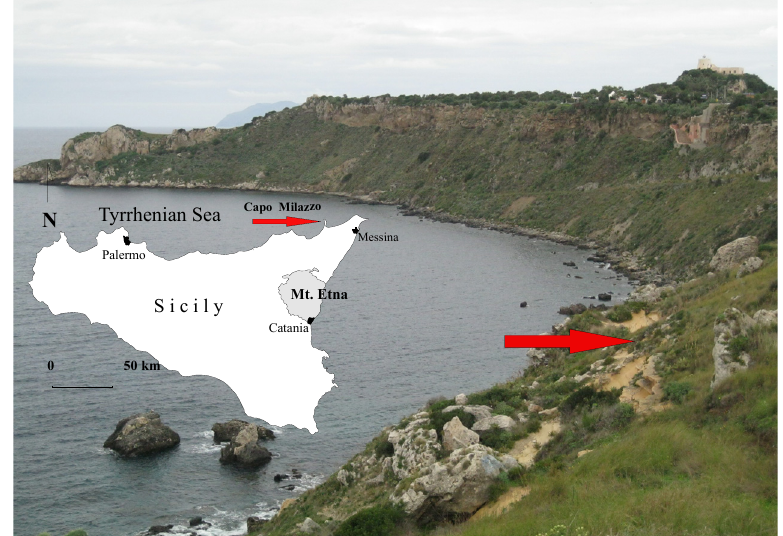
Figure 1. Geographical location of the Cape Milazzo Peninsula and Cala S. Antonino with the sandy-silty succession (marked by arrows).